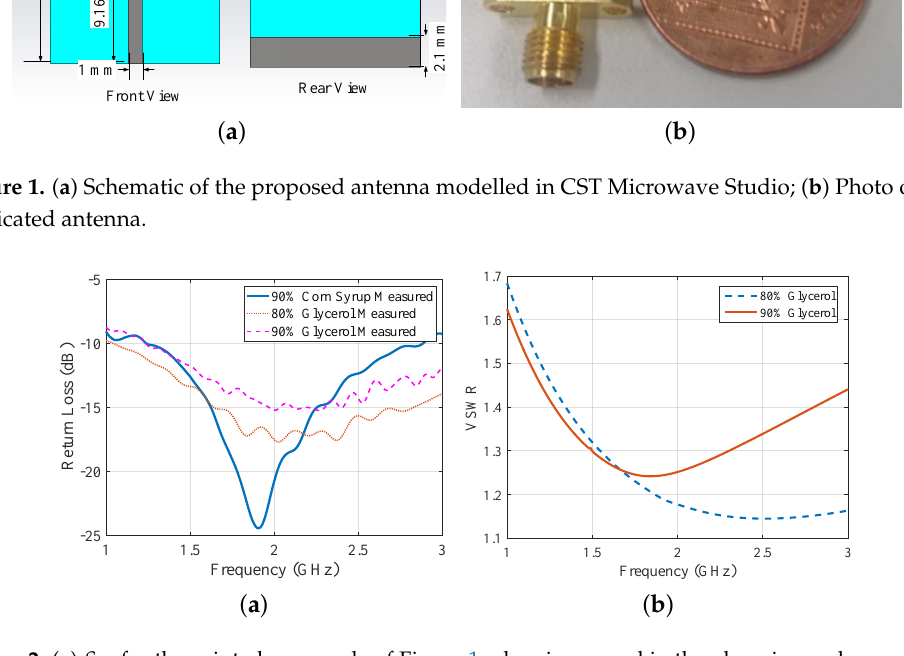
Figure 2. ( a ) S 11 for the printed monopole of Figure 1 when immersed in the glycerine and corn syrup mixtures measured in Figure 3; ( b ) Calculated voltage standing wave ratio (VSWR) of the antenna immersed in 80% and 90% glycerine–water mixtures, using CST simulations.